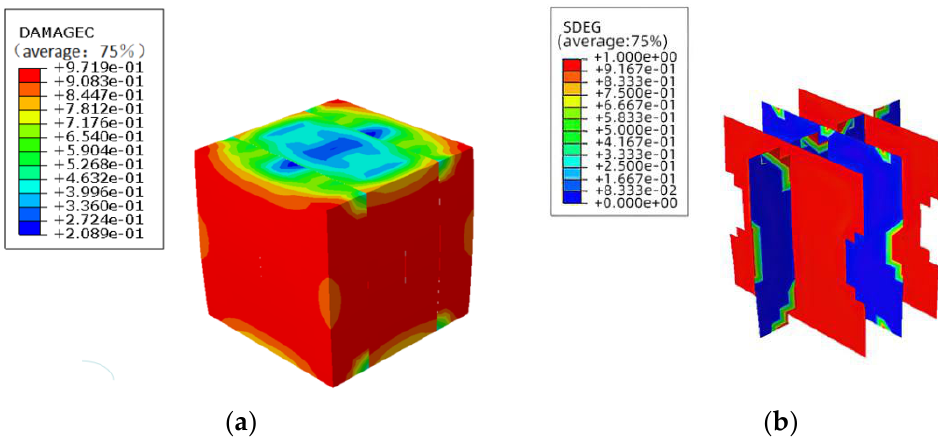
Figure 15. Damage cloud maps of specimen subjected to X-axis loading compression. ( a ) Concrete compression damage; ( b ) Adhesive unit damage .